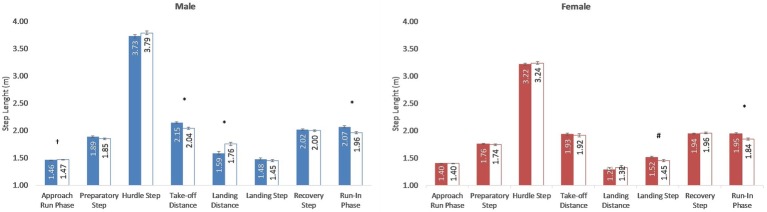
Mean step length (m) in the race phases of the elite-level (colored) and high-level (white) men and women athletes participating in the 60 m hurdler race of the 44th Spanish Indoor and 12th IAAF World Indoor Championships. Statistical inter-level differences: †p < 0.05; #p < 0.01; *p < 0.001.